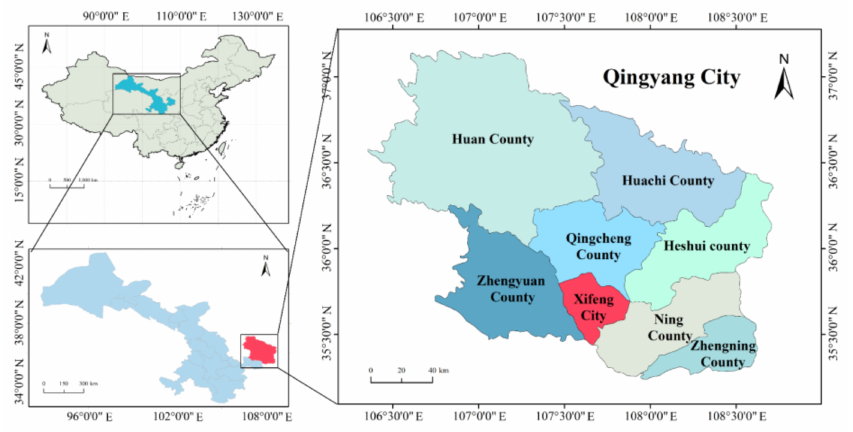
Figure 1. Location of the Qingyang city in Gansu Province,